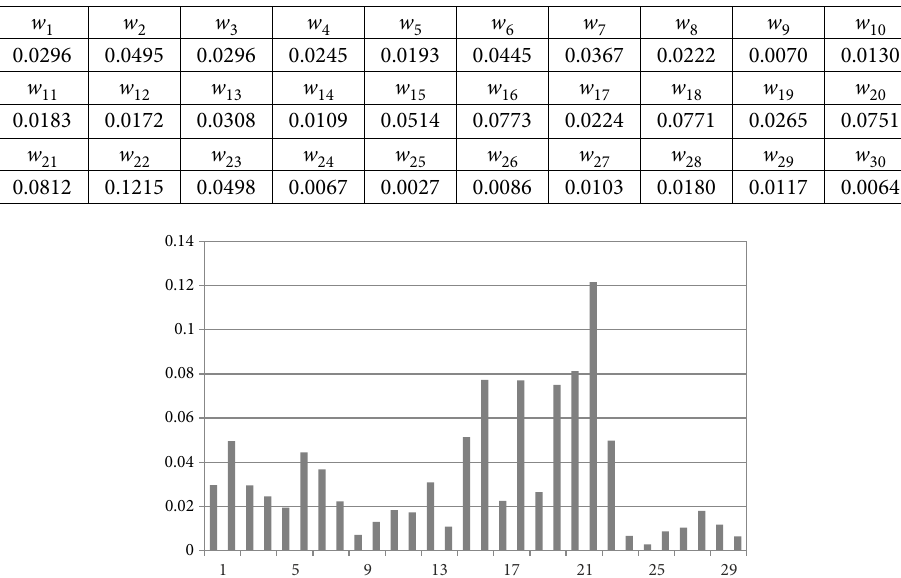
Figure 4. Objective criteria weights after using the aggregation operator